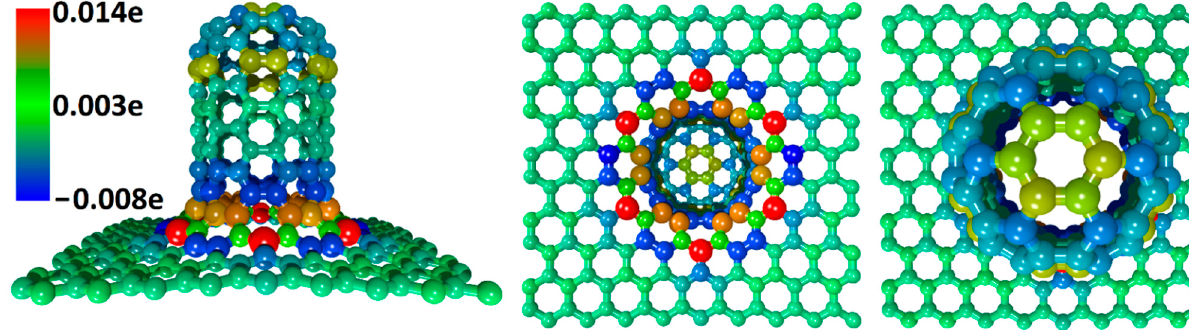
Figure 2. The charge distribution of the graphene–CNT (6,6) composite after optimization in SIESTA. The lack of charge is shown in red, while the excess is shown in blue.